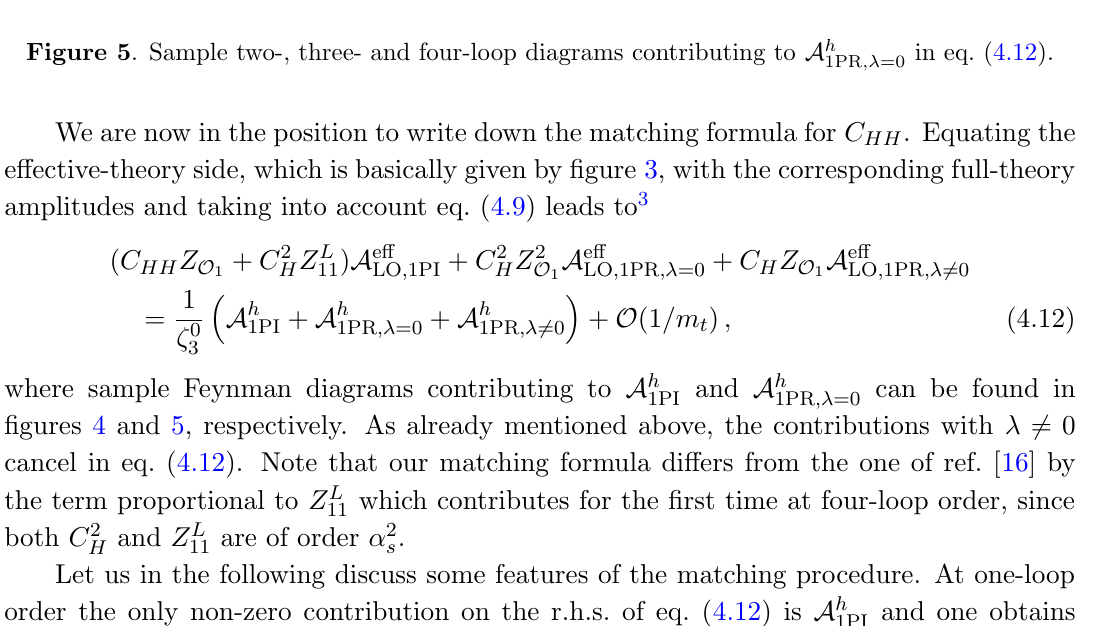
Figure 5 . Sample two-, three- and four-loop diagrams contributing to A h